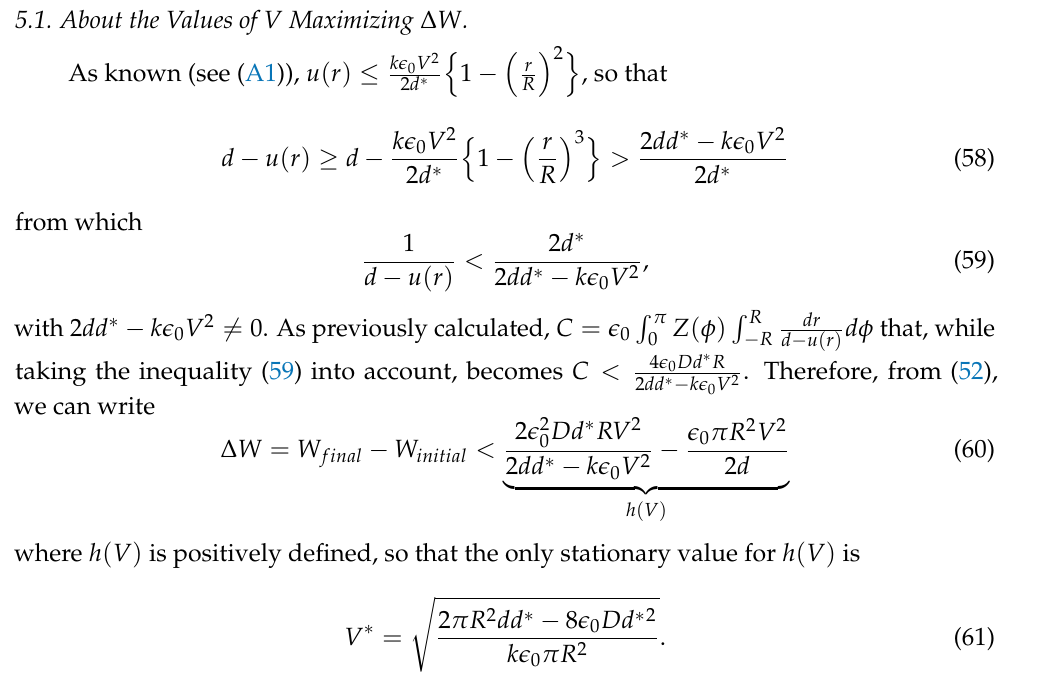
Figure 4. Area of possible values for ∆ W . As k decreases, this area increases by extending the possible values for T